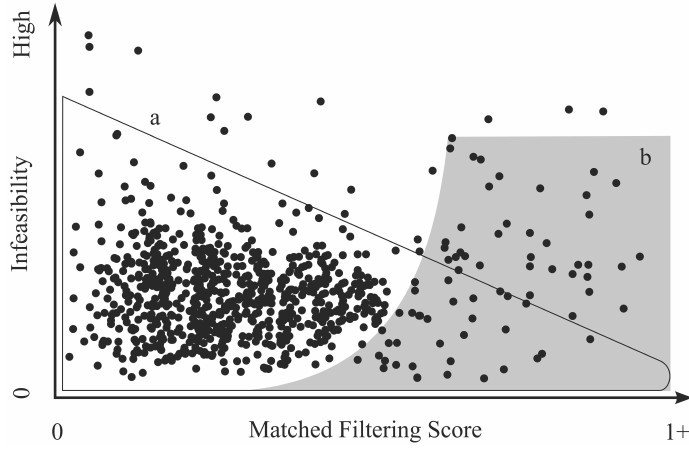
Figure 2. An example scatterplot of artificially generated matched filtering (MF) and infeasibility values, like those used during mixture tuned matched filtering (MTMF) post-processing. The delineation of properly classified reference plots (pixels) should theoretically follow the conical shape ( a ), however, previous research has instead indicated a nearly inverse shape as shown by ( b